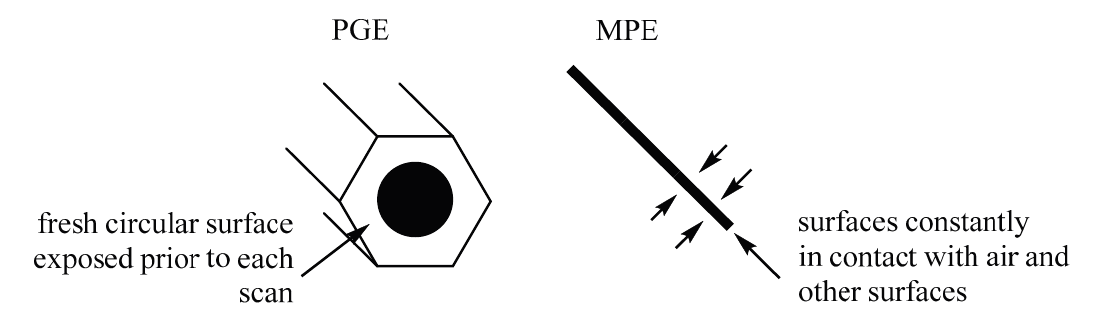
Figure 5. Diagram of PGE vs. MPE, highlighting the difference in exposed surface